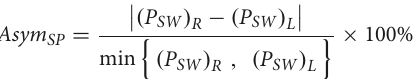
same foot. In this paper, we applied the IMU to measure